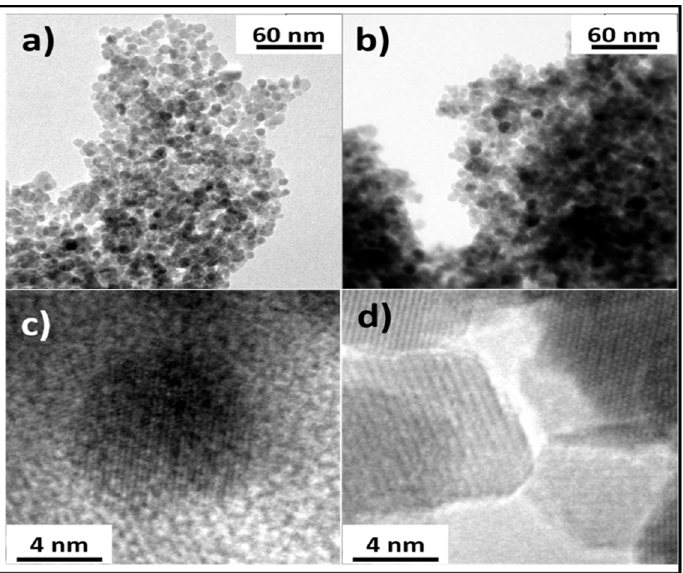
Figure 3. Bright field TEM image of ( a ) FO − CA and ( b ) FO − NA showing the nanoparticle structure of the samples. High resolution TEM image of ( c ) FO − CA and ( d ) FO − NA revealing the quasi − spherical and faceted shape of the particles synthesized in nitrogen or air reaction atmosphere, respectively.